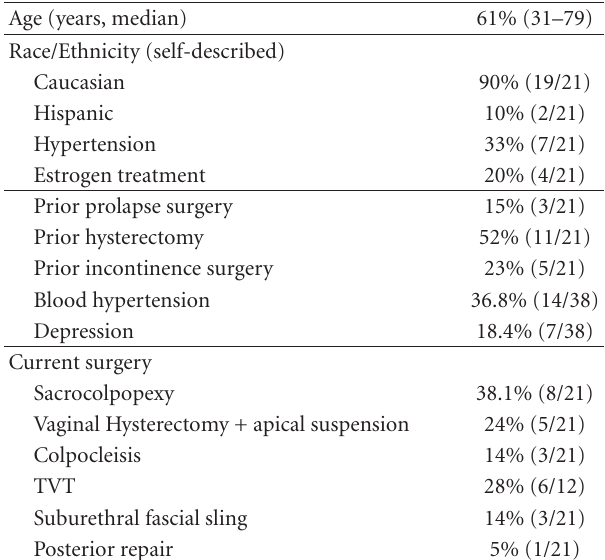
Table 1: Patient demographics and medical